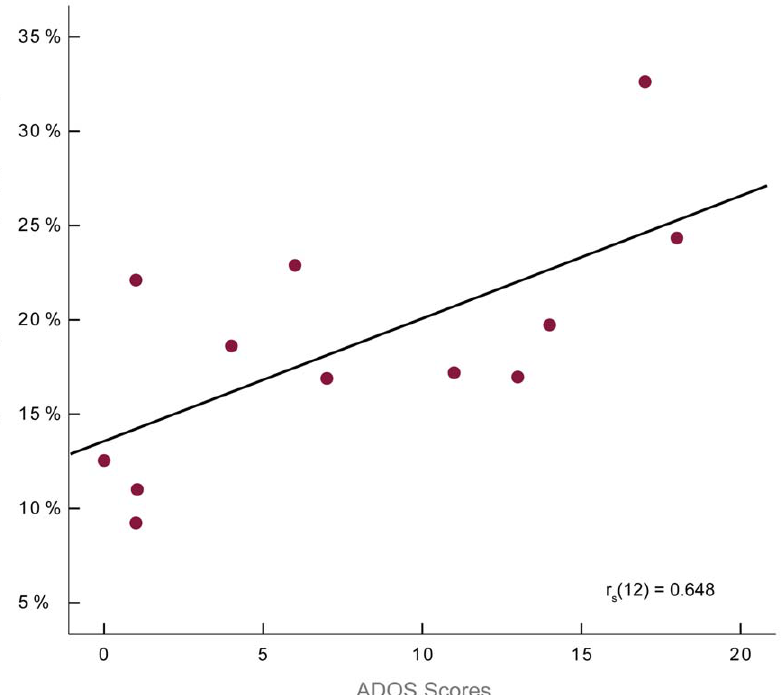
Figure 5. Coherent motion perception deficits correlate with measures of autistic symptom severity. A correlation was found between individual coherent motion perception thresholds at the shortest viewing duration and autistic symptoms, as measured by individuals’ total scores on the Autism Diagnostic Observation Schedule (ADOS).